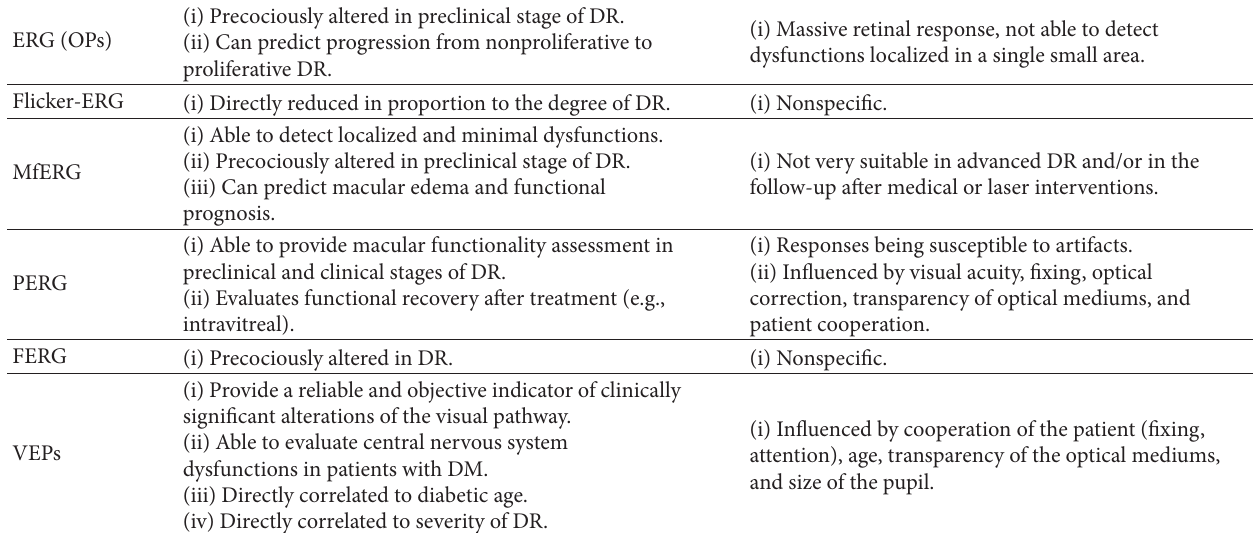
Table 3: Summary of the advantages (left side) and disadvantages (right) of electrophysiological techniques described in relation to DR. All techniques reported are noninvasive, safe, objective, and repeatable. Full knowledge and the use of them in clinical practice can provide useful information in preclinical evaluation, prognosis, and follow-up of